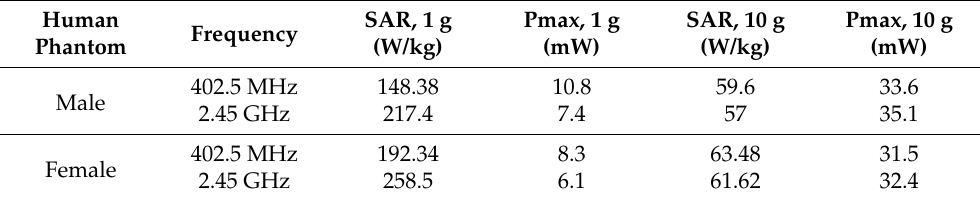
Table 4. Specific absorption rate and maximum permissible input